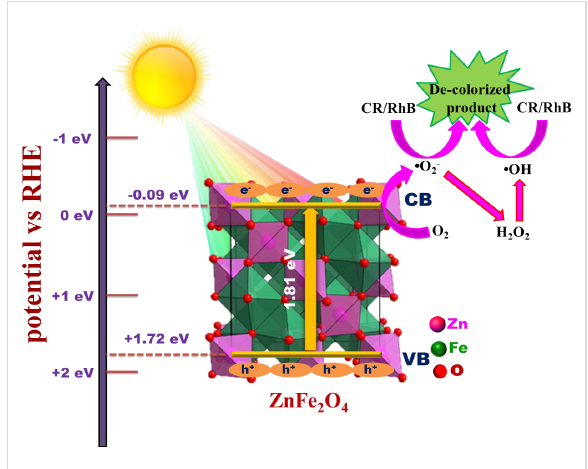
Figure 13: Reaction mechanism of the decolourization of Congo red and Rh B over ZFO-500.